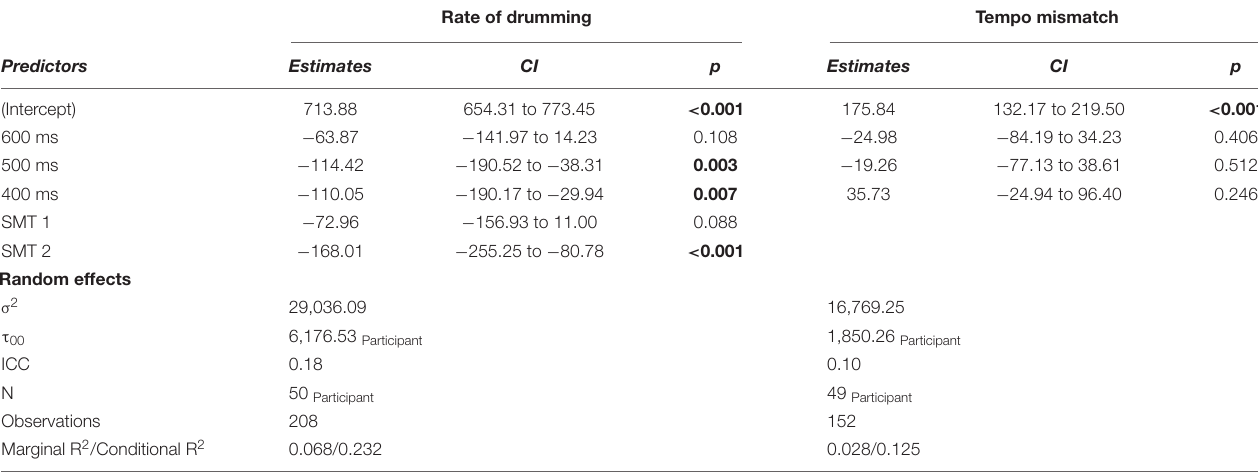
TABLE 2 | Table of coefficients for linear mixed effect models.